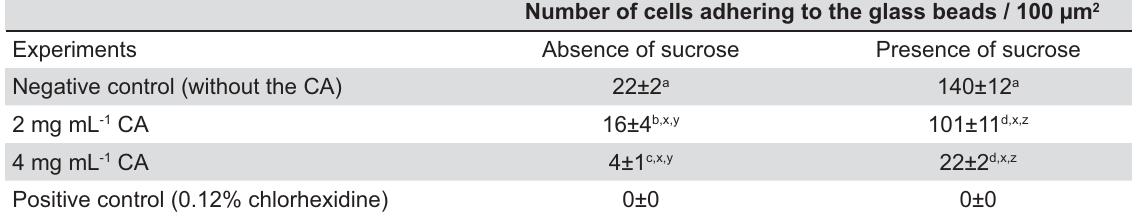
Table 1- Comparison of the cell population of S. mutans ATCC 25175 adhering to the glass surface when grown on the glass beads in the presence of different concentrations of crude aqueous Piper betle L. extract (CA), without or with sucrose (1%). (Statistical analysis; two-way ANOVA; scanning electron microscope at